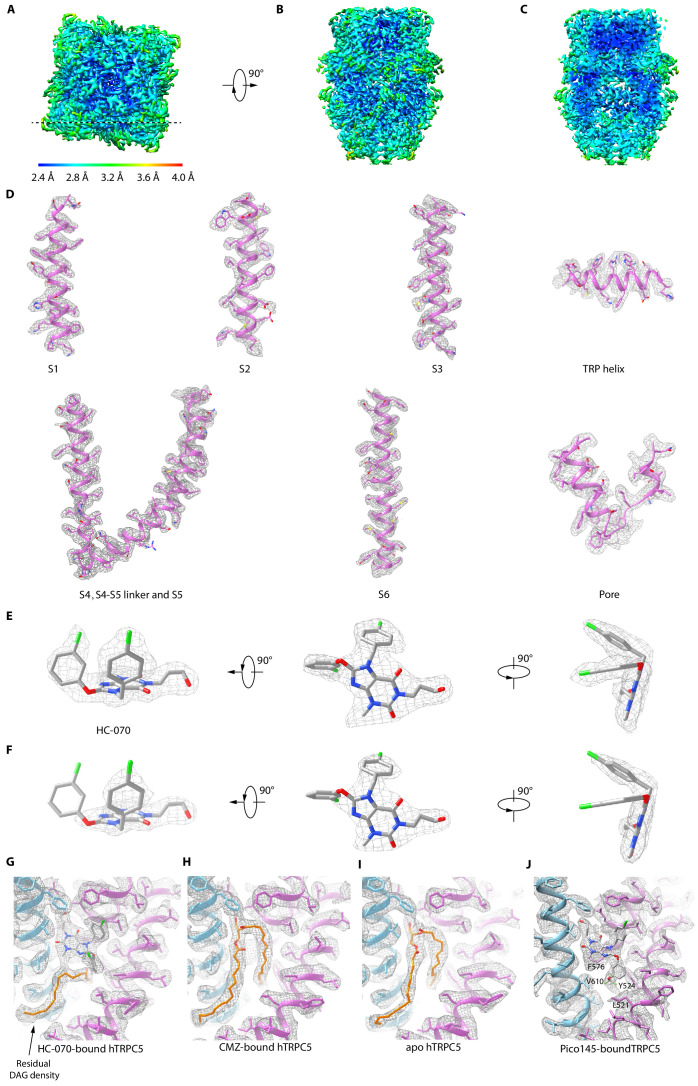
Cryo-EM map of HC-070-bound human TRPC5 (hTRPC5).(A–C) Cryo-EM map of HC-070-bound hTRPC5 colored by local resolution, shown in top view (A), side view (B), and cross-section (C). The position of cross-section is shown as dashed line in (A). (D) Cryo-EM density map (contoured at 3 σ, gray mesh) with atomic model superimposed. (E–F) Cryo-EM density map of HC-070 shown in different views contoured at 3 and 7 σ, respectively. (G–J) Cryo-EM densities of HC-070-binding pocket in (G) HC-070-bound, (H) clemizole (CMZ)-bound, (I) apo, and (J) Pico145-bound hTRPC5 maps, contoured at 3.8 σ.